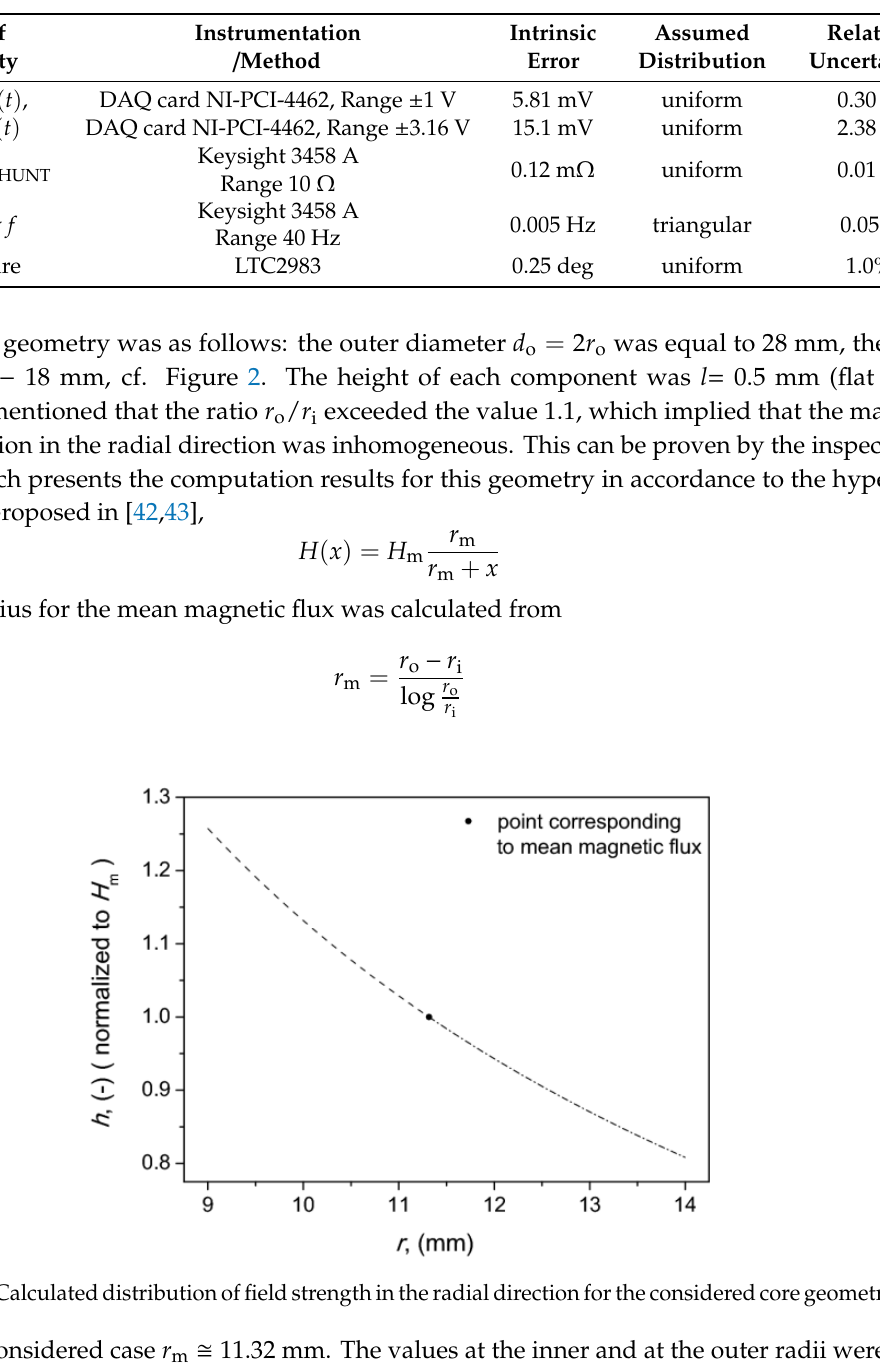
Table 2. B-type uncertainty of the measurement method.